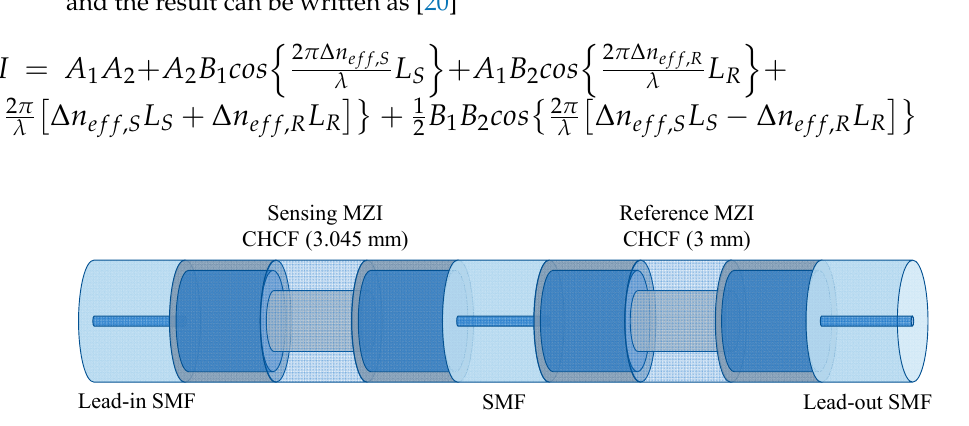
Figure 5. Variations of the magnification ( M ) as a function of the percentage of the size difference.